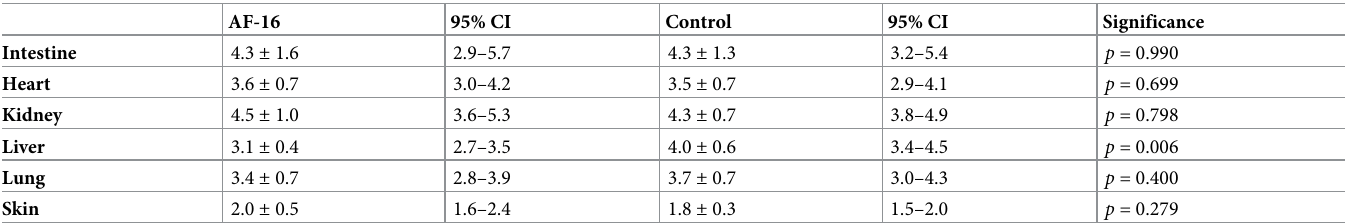
Table 5. Wet-to-dry